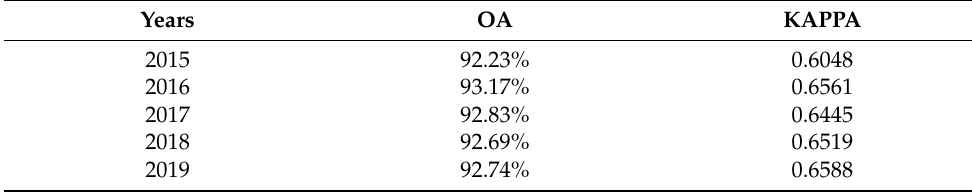
Table 1. The extraction